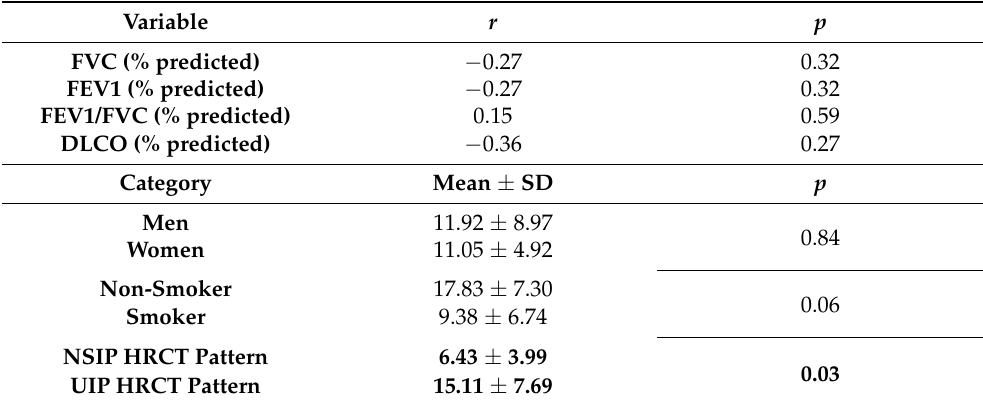
Table 4. Relationship of TAng frequency with characteristics of other AD-ILD + patients.